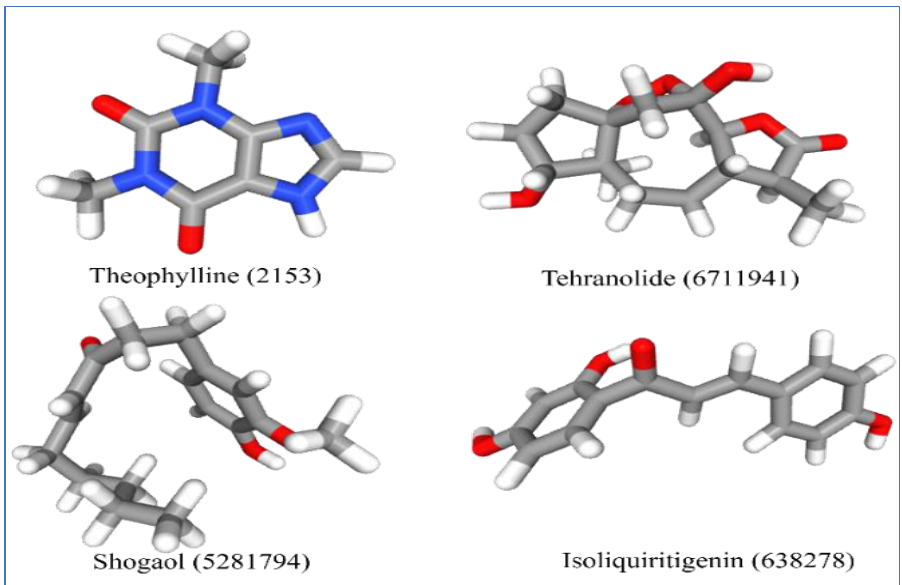
Figure 3. Three-dimensional structure of selected inhibitors with their PubChem CID.